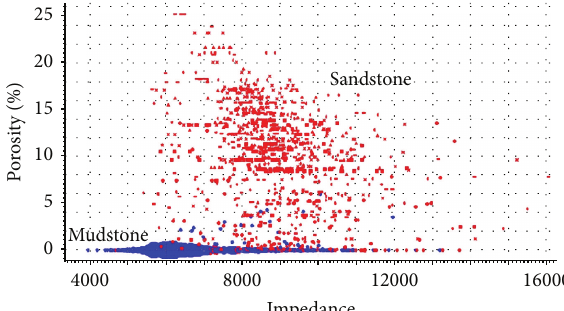
Figure 6: The relationship between porosity and p-impedance of sandstone and mudstone.